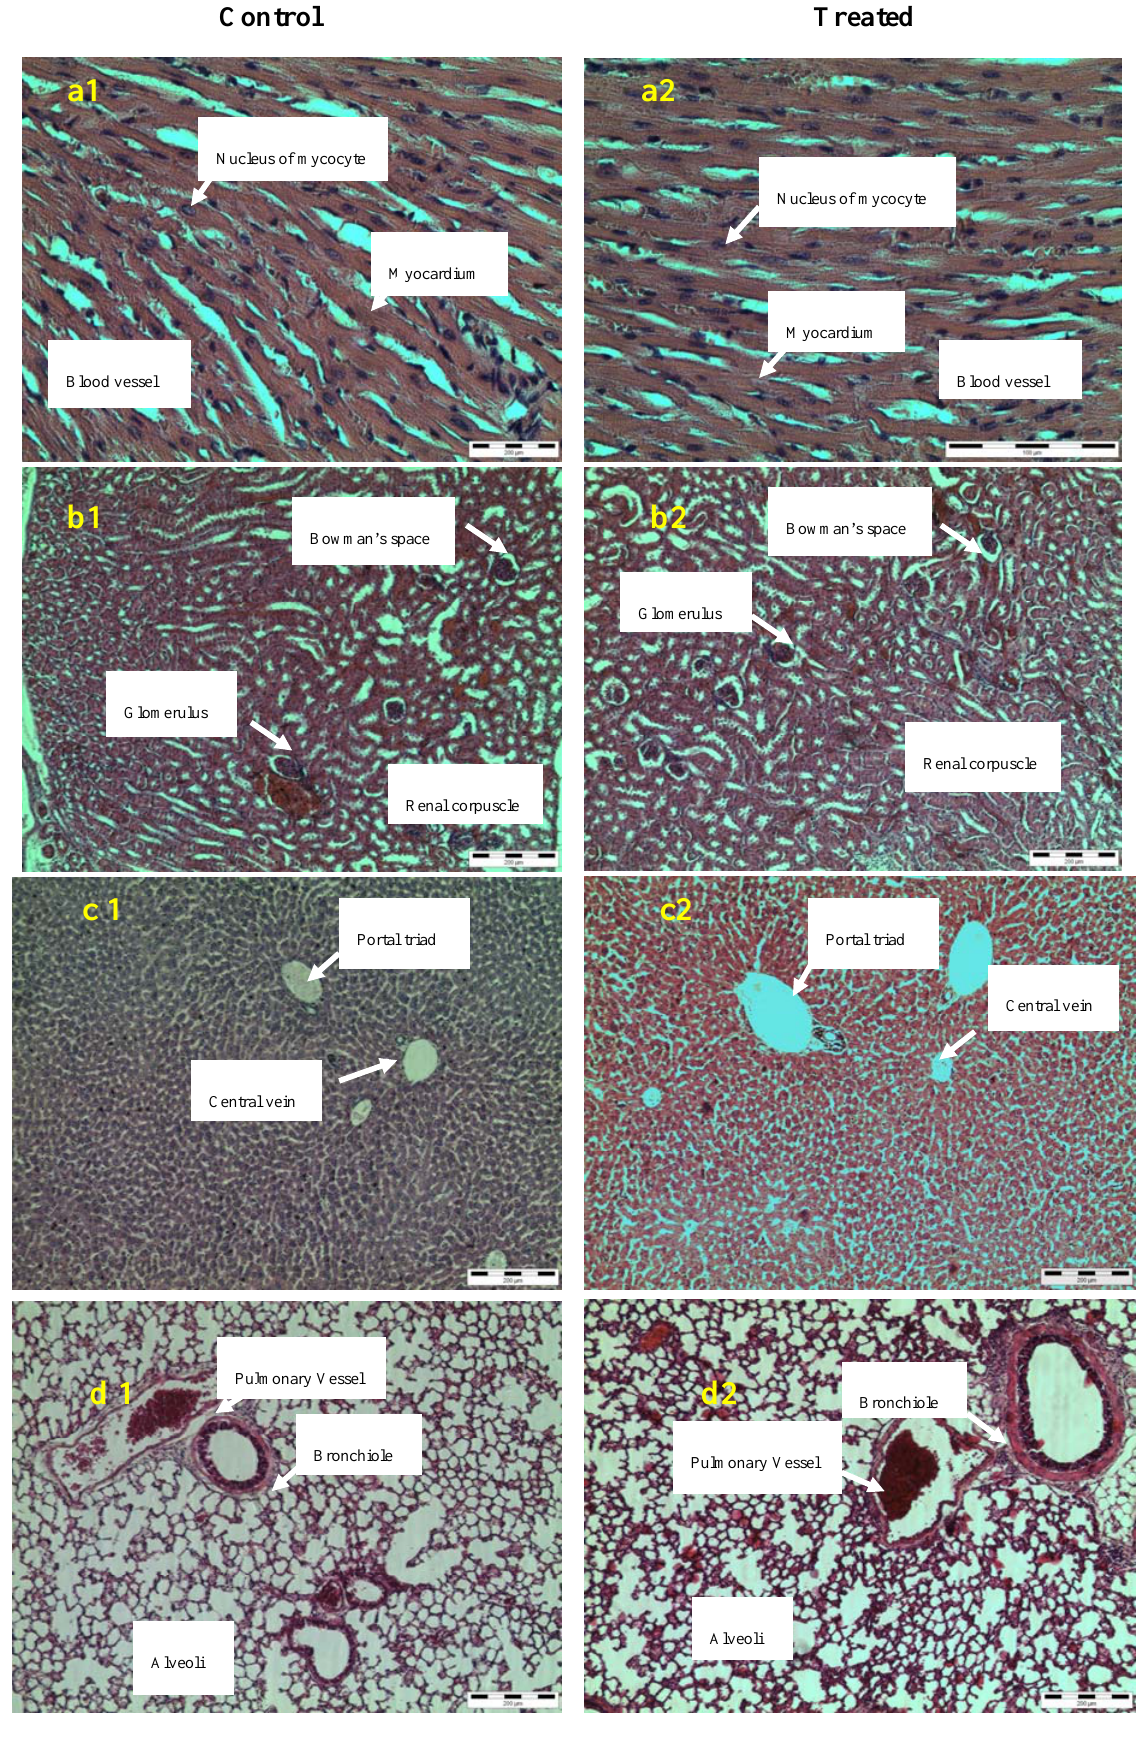
Figure 2. Histological examination of heart ( a ), kidney ( b ), liver ( c ), lung ( d ) and spleen ( e ). Control